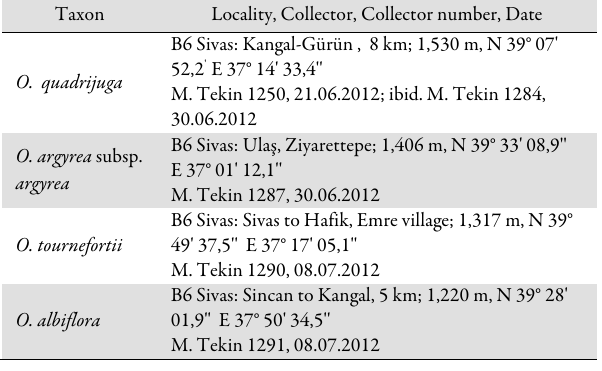
Table 1. Natural habitat of investigated specimens of Onobrychis taxa Taxon